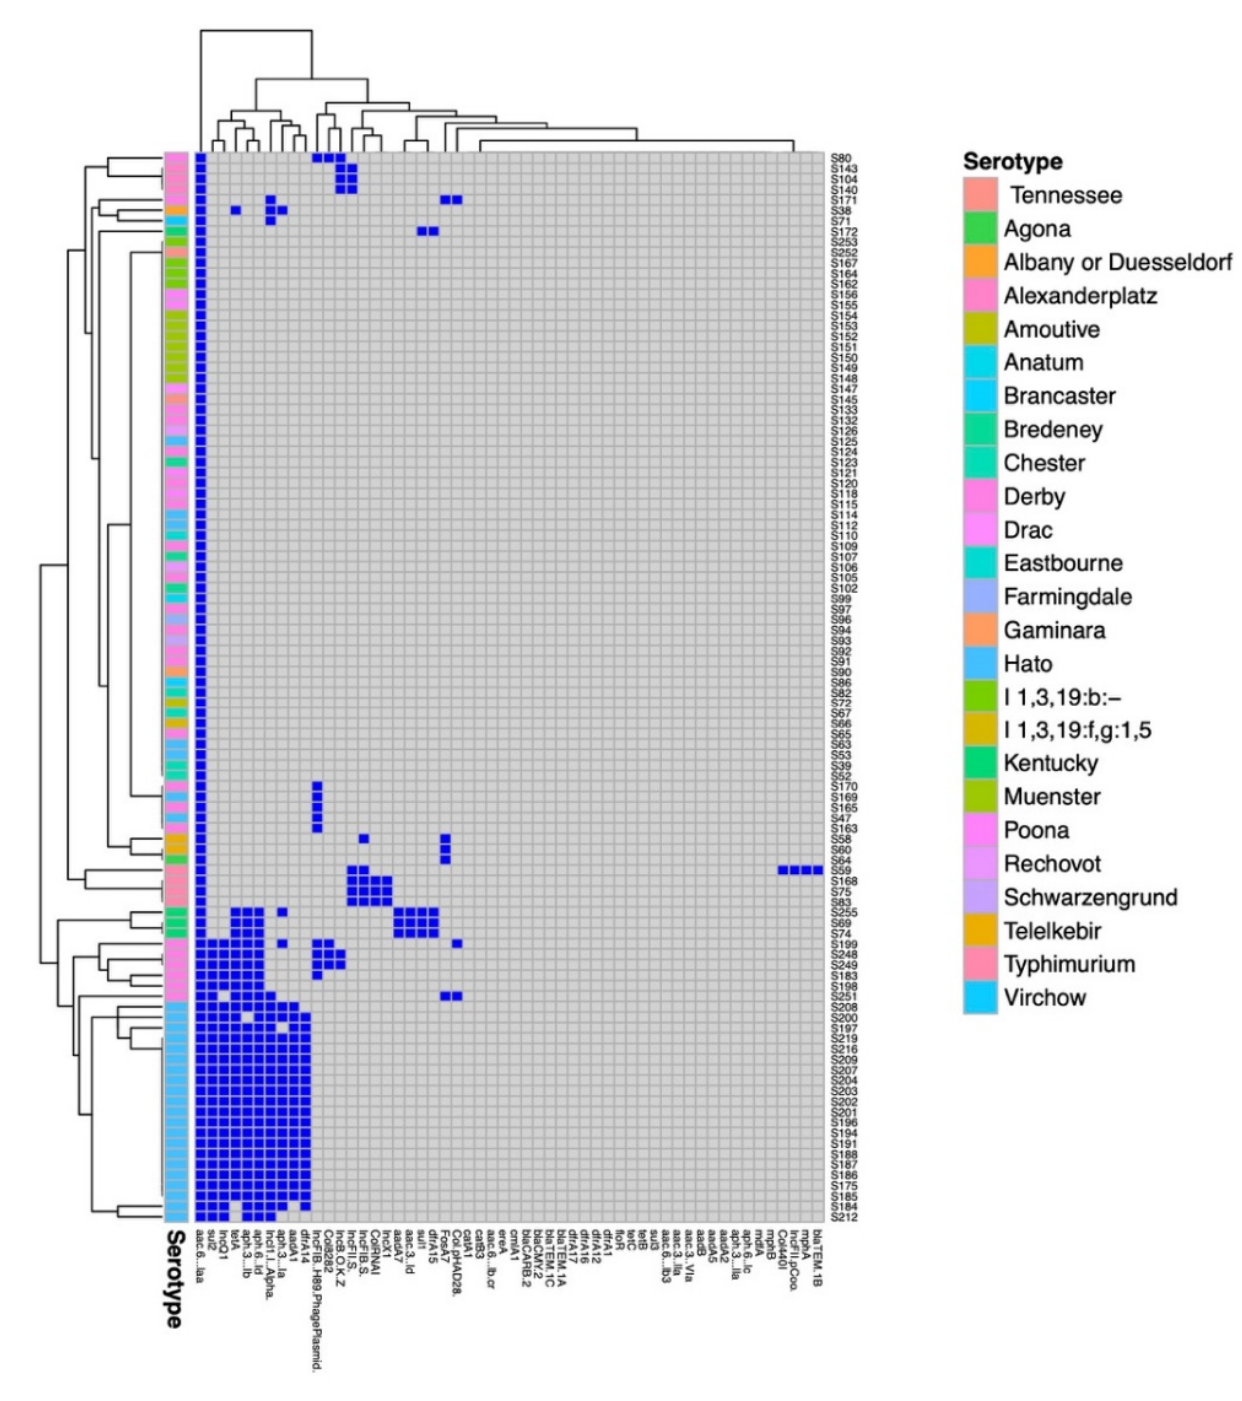
Figure 1. Antibiotic resistance genes and plasmid replicons present in Salmonella isolated from slaughtered chickens in Burkina Faso. Genes and replicons present are indicated by dark blue squares; absent genes and replicons are indicated by gray squares. The serotypes are indicated by colored blocks as defined in the key. Relationships based on presence/absence of these genetic elements are indicated by the supporting dendrograms.